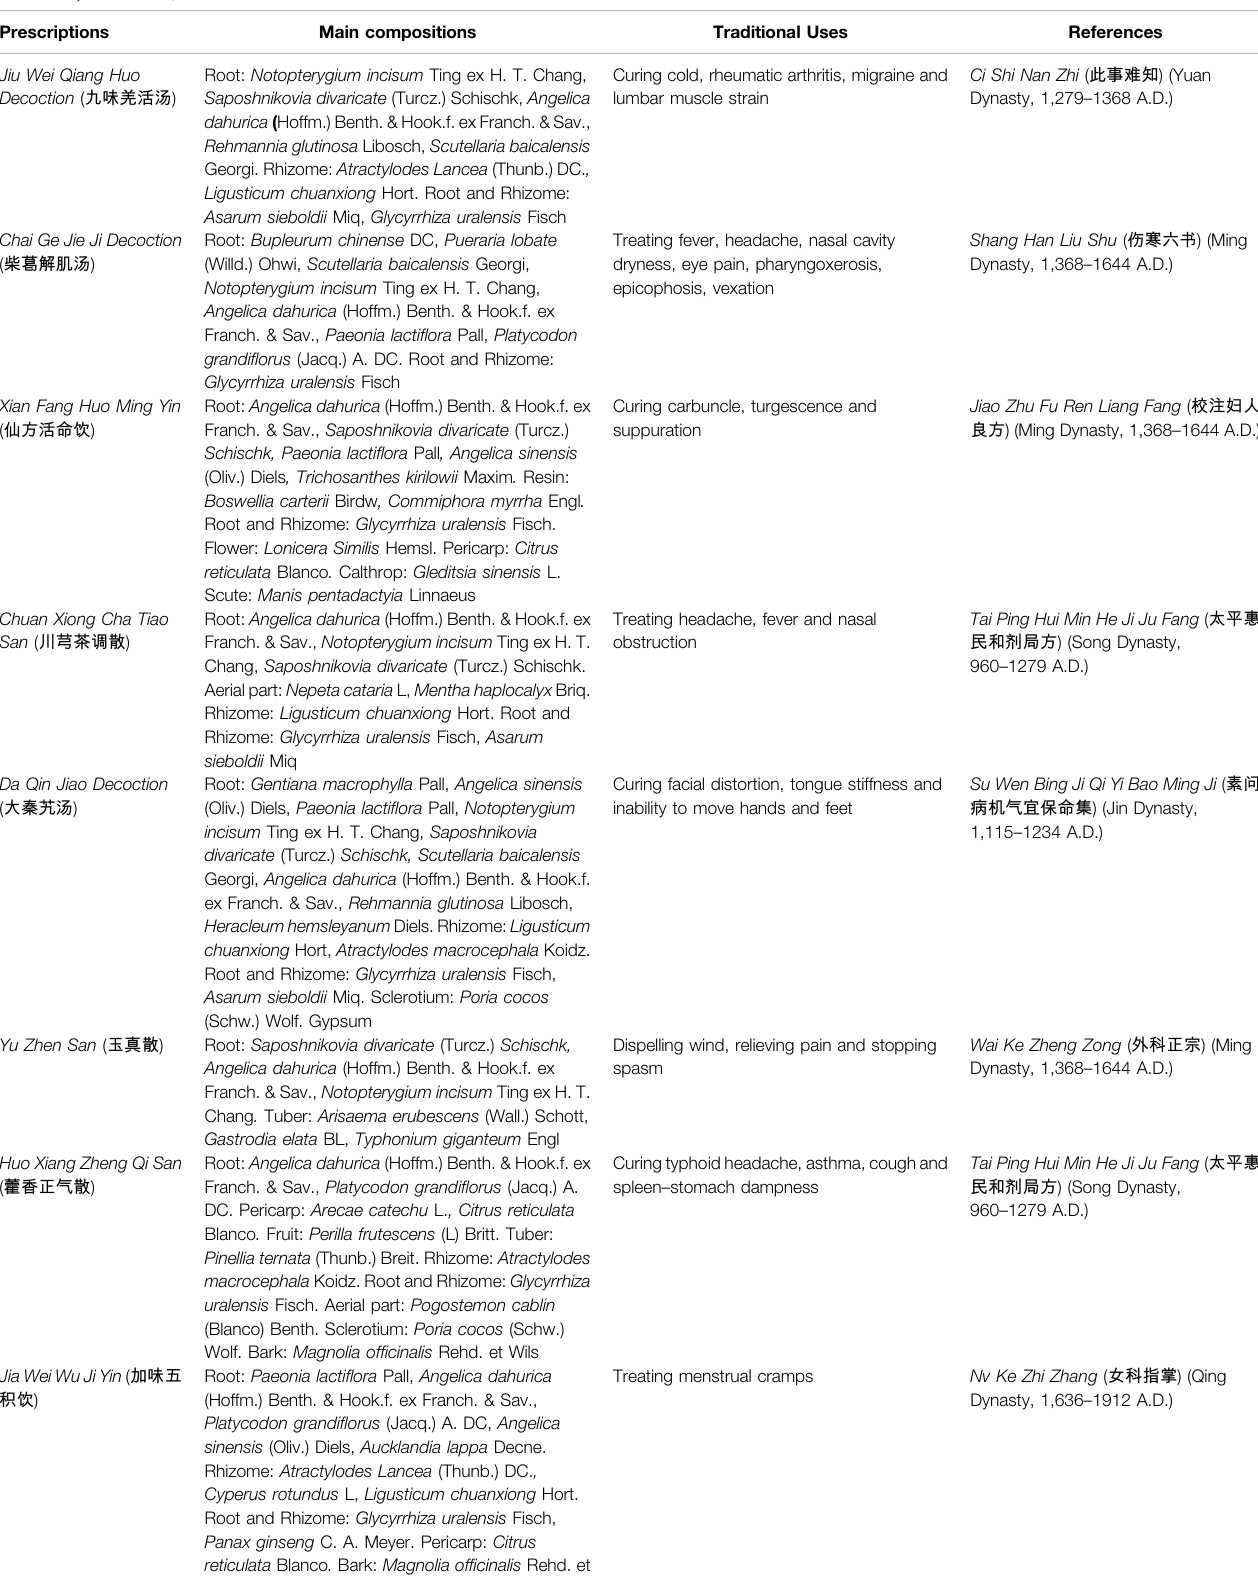
TABLE 2 | The Prescriptions and traditional uses of A. dahurica root in China.